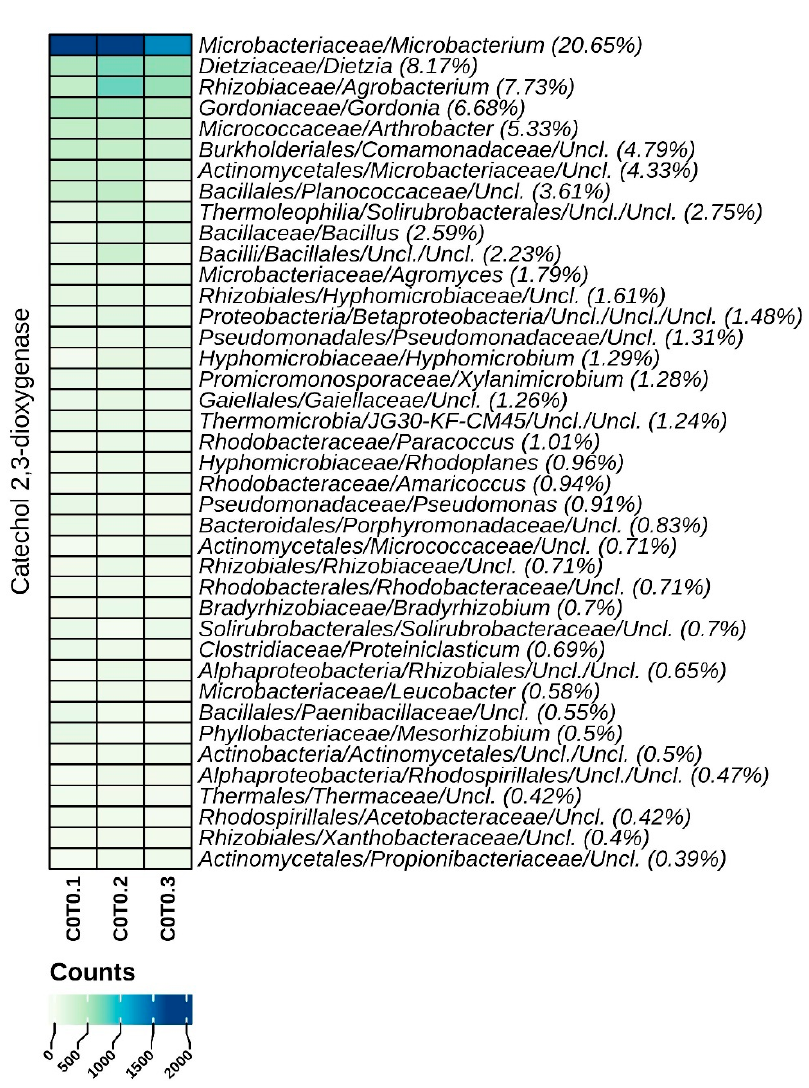
Figure 5. Functional Heatmaps of the Cathechol 2,3-dioxygenase contribution by identified ASVs aggregated at the Genus level, as inferred by PICRUSt2 in the three biological replicates. On rows, the nearest identified taxonomic level for each contributing ASV is reported, followed by its relative percentage contribution to the functional feature. Hierarchical clustering of columns was performed by Pearson correlation, based on Euclidean distance.